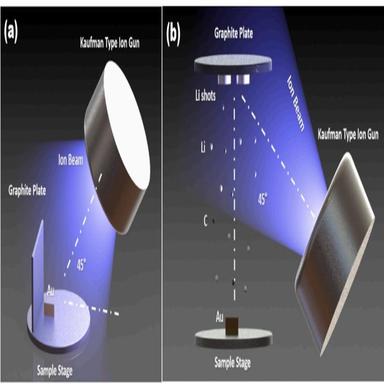
Schematic representation of a sample setup using ion irradiation for (a) the fabrication of AuNPs, (b) the deposition of a Li-C nanocomposite film onto the AuNPs and (c) the deposition of carbon onto the SiO2/Si substrate.